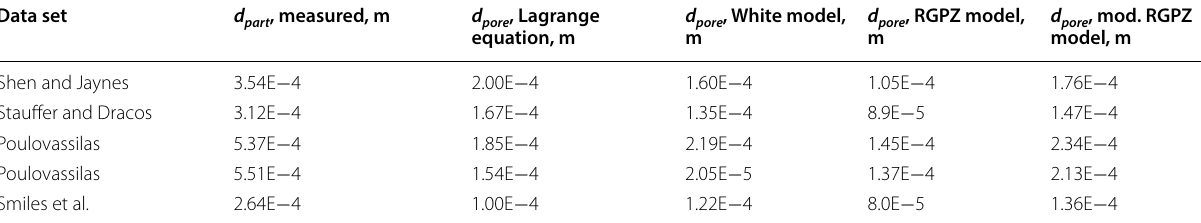
Table 1 Comparison of pore diameters based on particle diameters with pore diameters from capillary pressure measurements